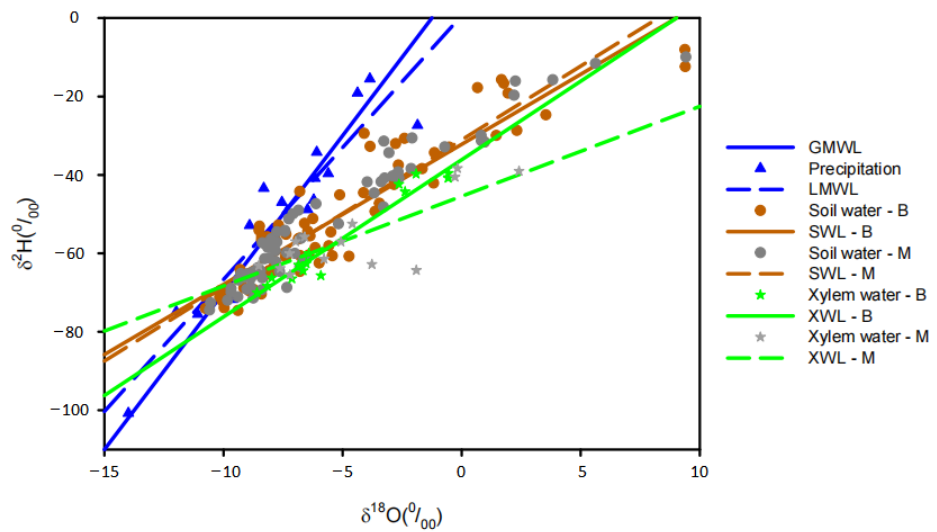
Figure A1. δ 2 H- δ 18 O relationship in precipitation, groundwater, soil water, and xylem water. The solid blue triangle denotes precipitation. The brown and gray solid circles denote the soil water of Bromus inermis (B) and Medicago sativa (M) grasslands, respectively. The green and gray stars denote the xylem water of Bromus inermis (B) and Medicago sativa (M), respectively. The blue solid line, blue dash line, brown solid line, brown dash line, green solid line and green dash line represent the global meteoric water line (GMWL), local meteoric water line (LMWL), soil water line (SWL) of Bromus inermis grassland (B), SWL of Medicago sativa grassland (M), xylem water line (XWL) of Bromus inermis (B) and XWL of Medicago sativa (M), respectively.